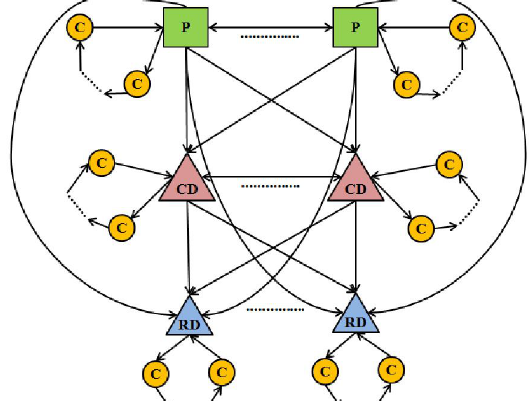
Fig. 1. Distribution network (Hamidi et al., 2011,